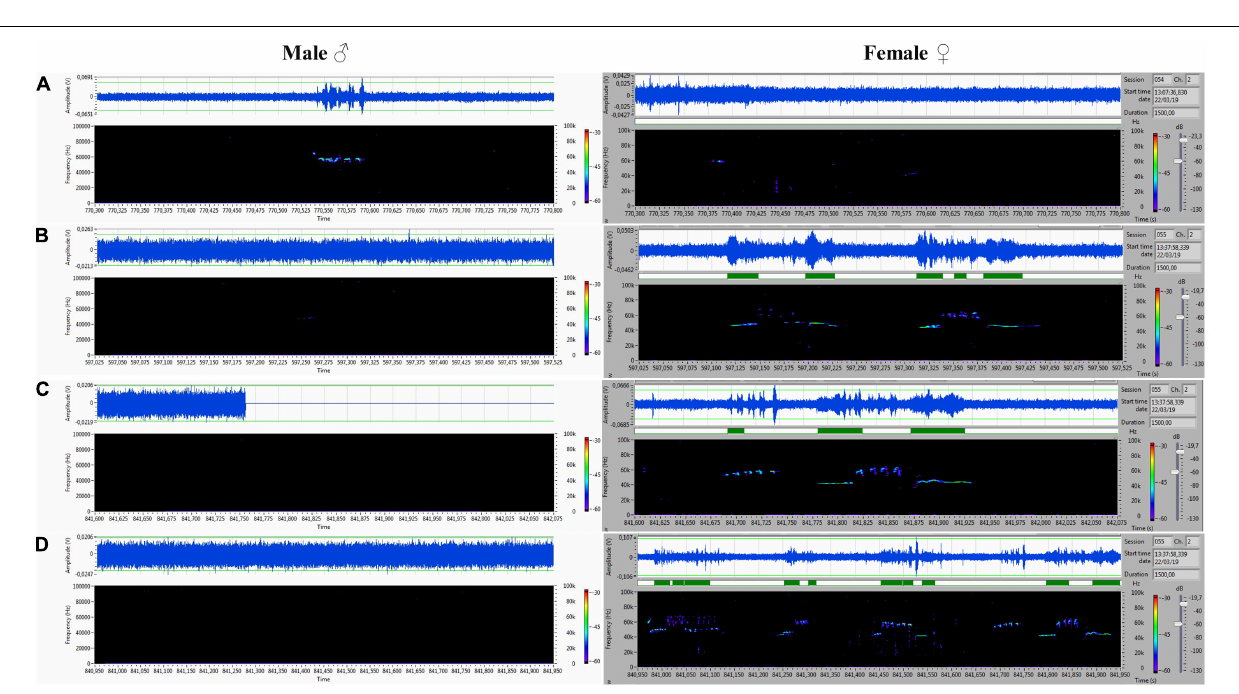
FIGURE 7 | (A) Frequency-modulated non-trill (complex) emitted by the male. Female emitted two forms of short type. (B–D) Very intensive, frequency-modulated USV with trills and composite clusters of signals emitted by the female. The male was